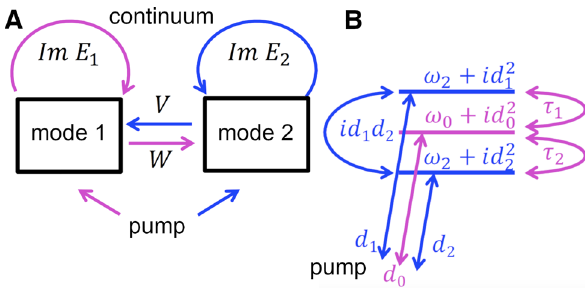
Figure 3: (A) Schematic of interaction between two-coupled eigenmodes of an open dielectric resonator. Arrows illustrate individual couplings of the modes to the continuum and couplings between the modes via the continuum. (B) Schematic of the three- level multipolar model for the formation of the quasi-BIC state captured by the Hamiltonian Eq.